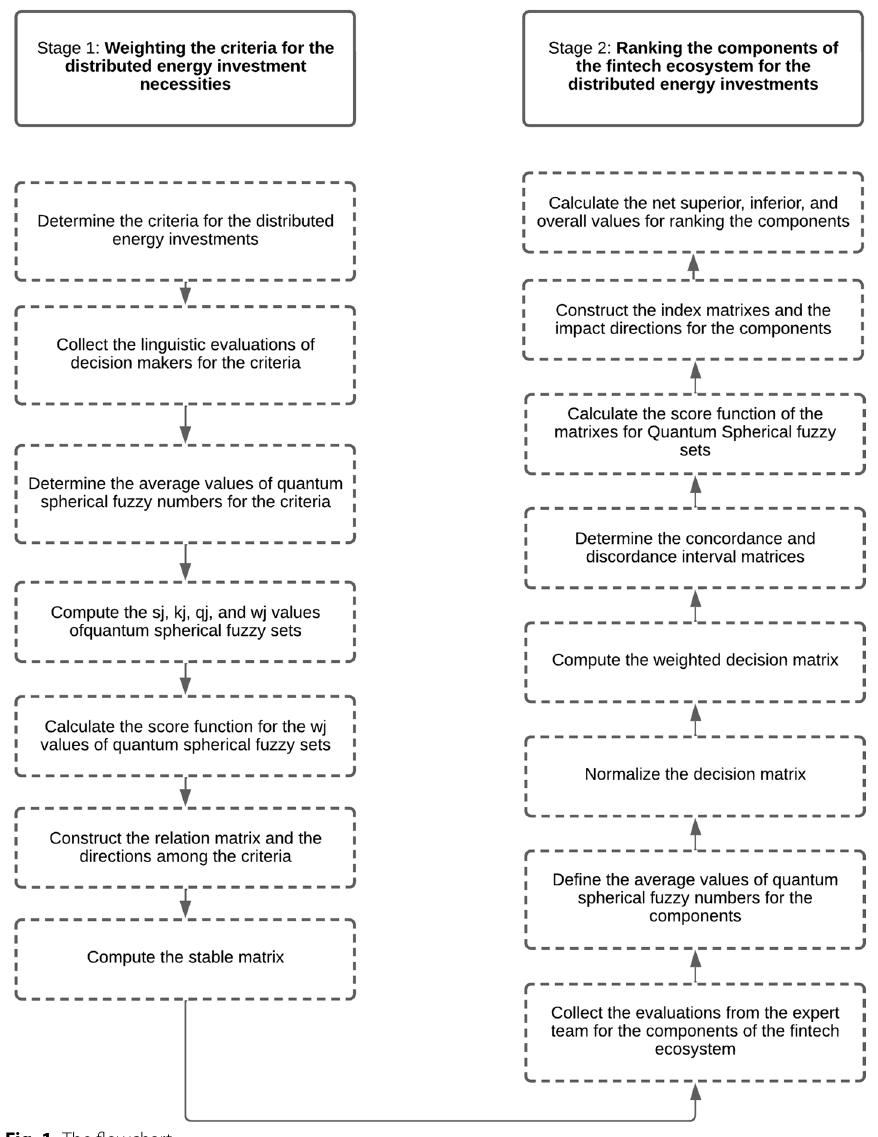
Fig. 1 The flowchart